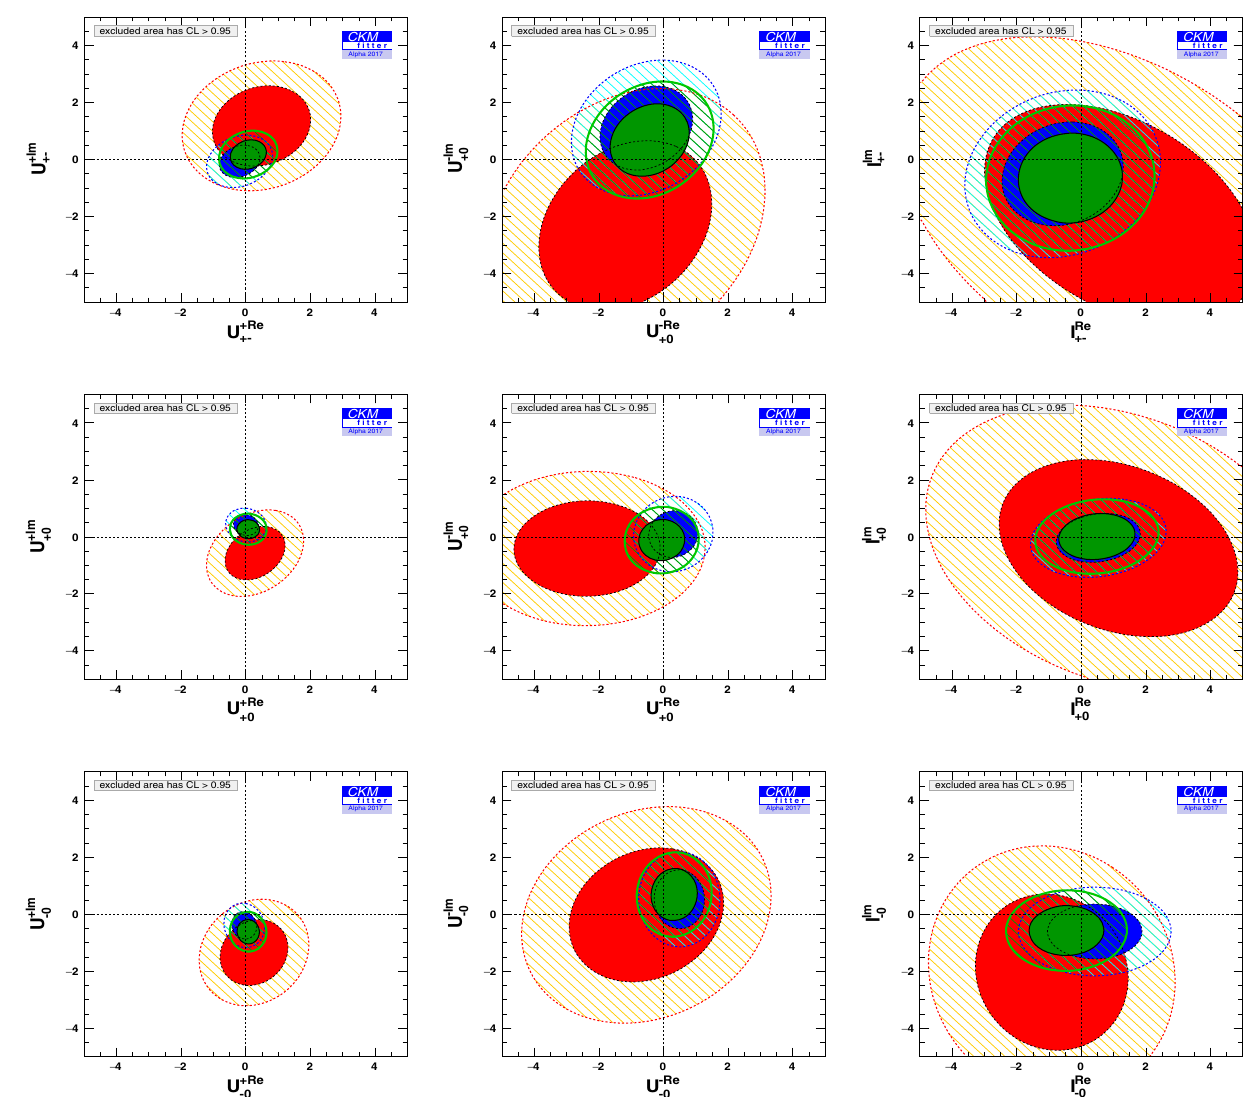
Fig. 47 Experimental measurements of the interference-related U and I parameters from BaBar ( blue area ) and Belle ( red area ). The green shaded area represents the world